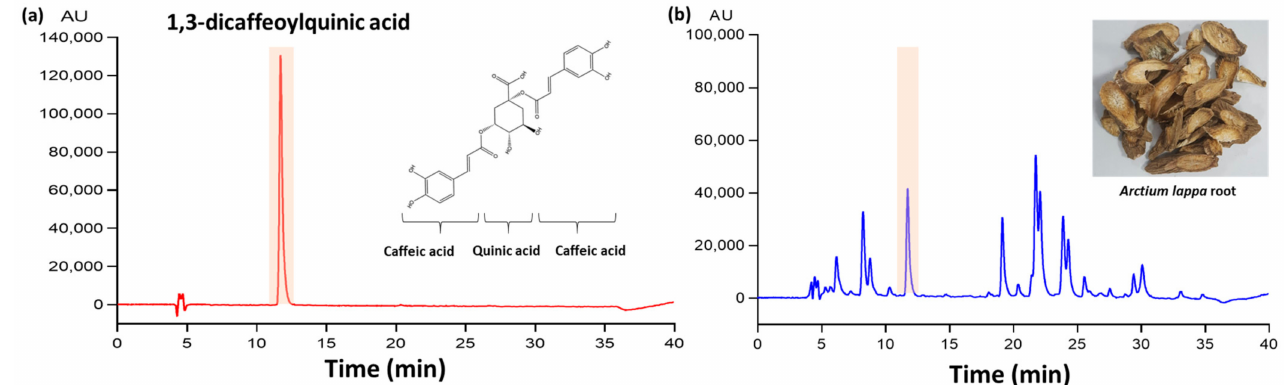
Figure 1. HPLC chromatogram of ( a ) 1,3-dicaffeoylquinic acid (1,3-diCQA) as standard compound and ( b ) Arctium lappa root extract (AE). The concentration of 1,3-diCQA was 1.35 ± 0.02 mg/g